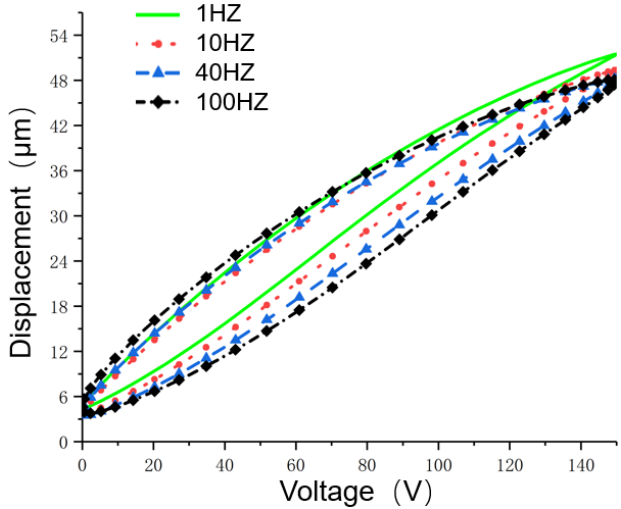
Figure 3. Hysteresis graph.